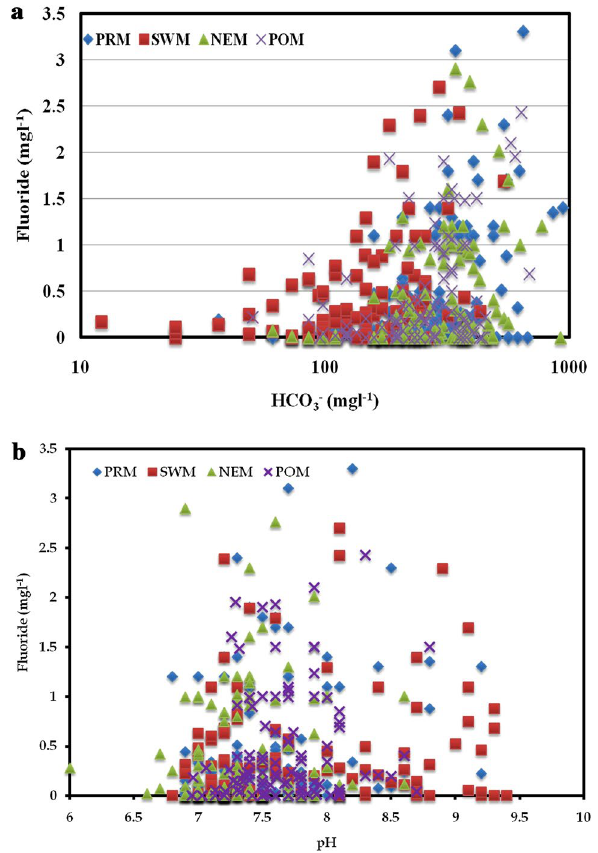
Fig. 4 a Variation of F − concentrations with HCO − 3 and b F − concen- trations with pH in groundwater samples from Tuticorin